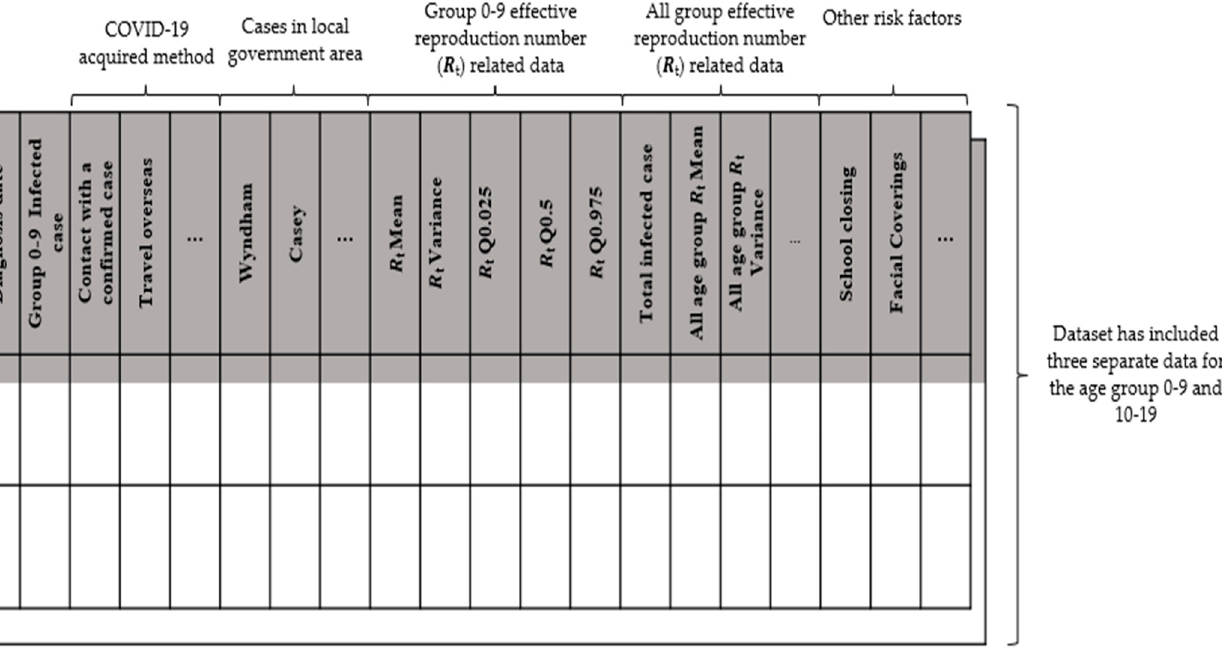
Figure 2. Sample dataset for the COVID-19 infection simulation model. The dataset includes the daily number of infections in that age group, the method of acquisition, the local government area, the e ff ective reproduction number (Rt), and the policy indicator, etc.